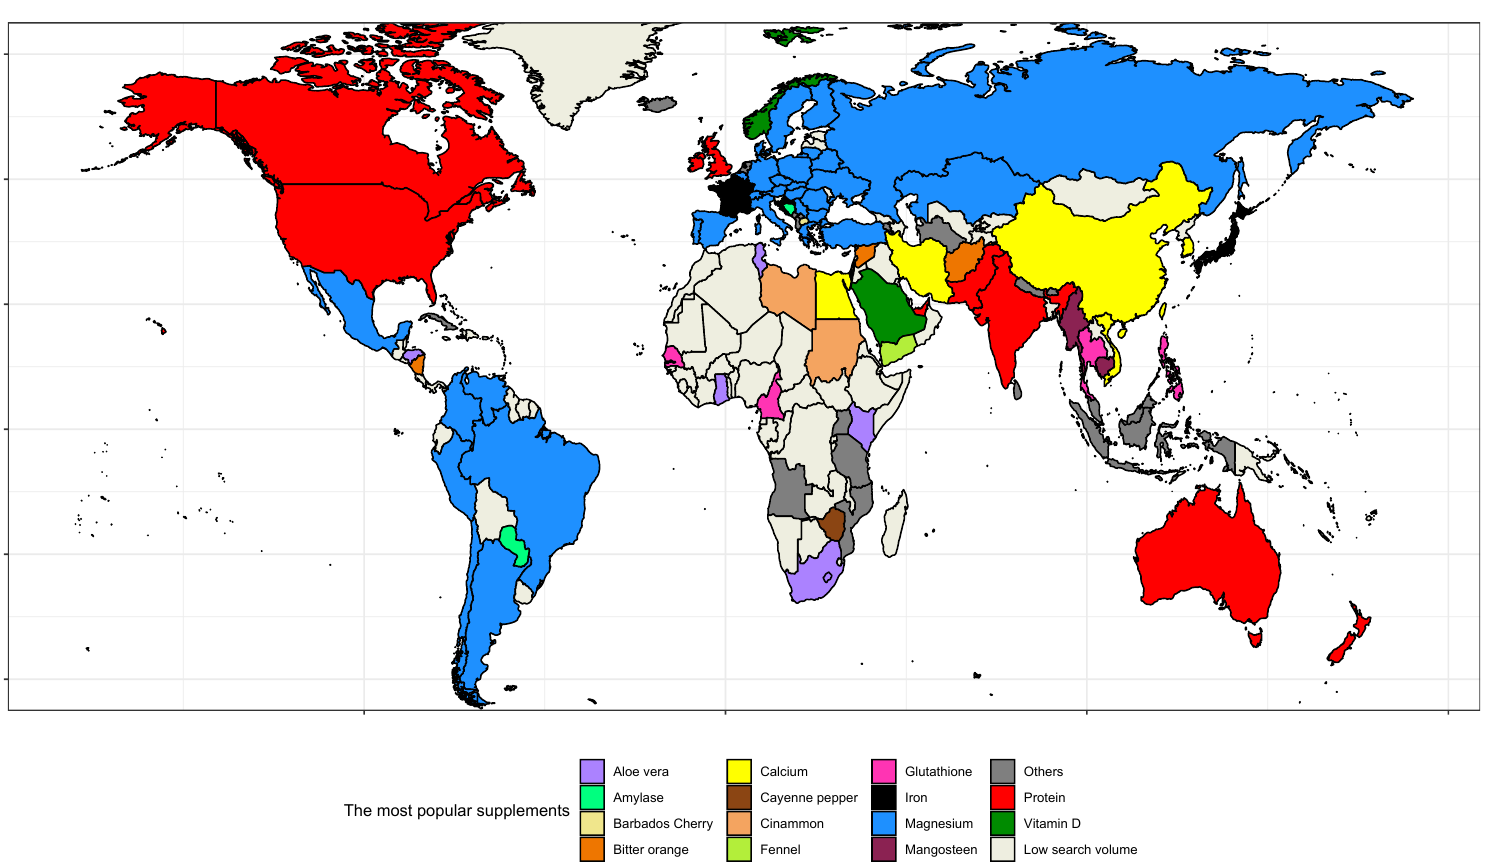
Figure 2. Supplements with the greatest interest by country. Countries with unique most popular supplements: Albania, boron; Angola, passion fruit; Armenia, burdock; Bhutan, cordyceps; Brunei, alfalfa; Cuba, chondroitin sulfate; Iceland, astaxanthin; Indonesia, garlic; Kosovo, iodine; Malaysia, vitamin C; Mauritius, holy basil; Montenegro, goji; Mozambique, Yohimbe; Nepal, ashwagandha; Netherlands, cobalamin; Sri Lanka, 4-aminobenzoic acid; Tanzania, nickel, Turkmenistan, glycine; Uganda,